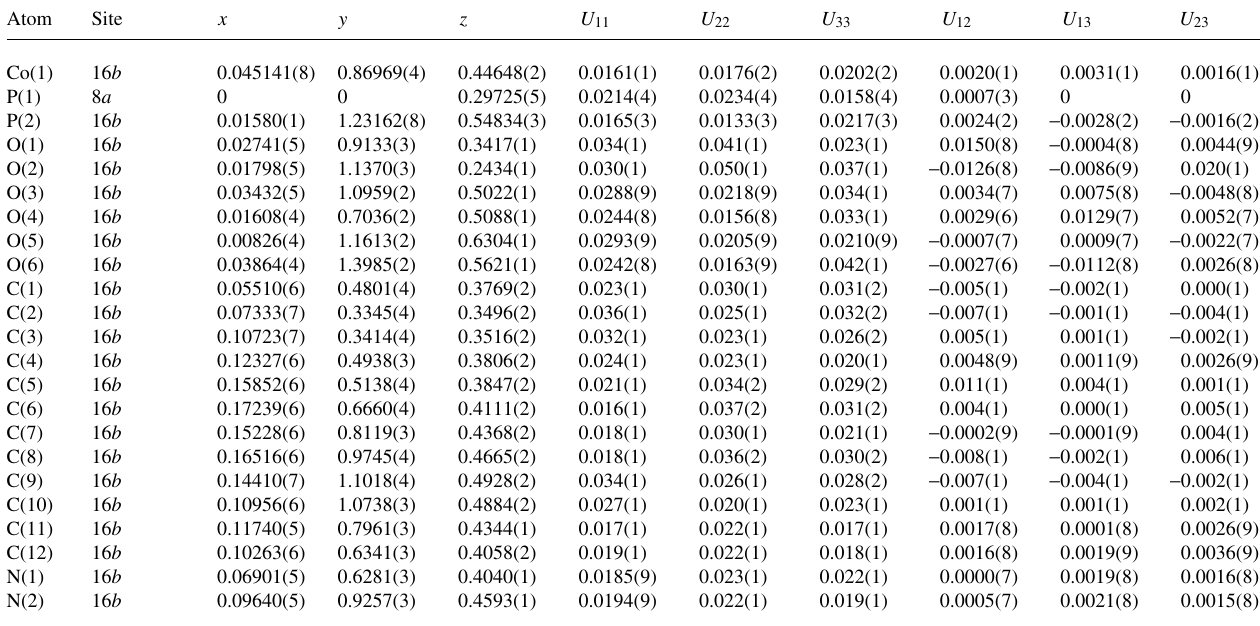
Table 3. Atomic coordinates and displacement parameters (in Å 2 ) .